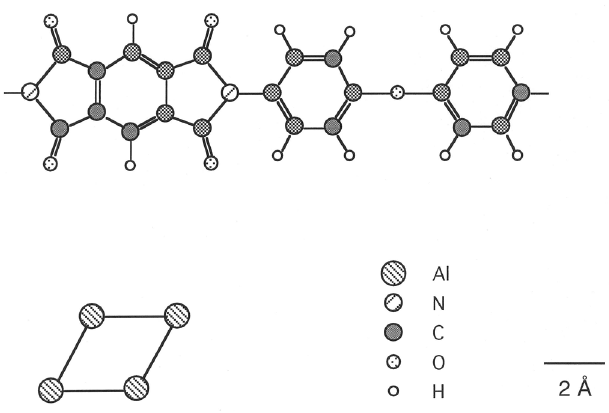
Figure 1. Structure of PMDA-ODA polyimide and Al (111) unit cell.